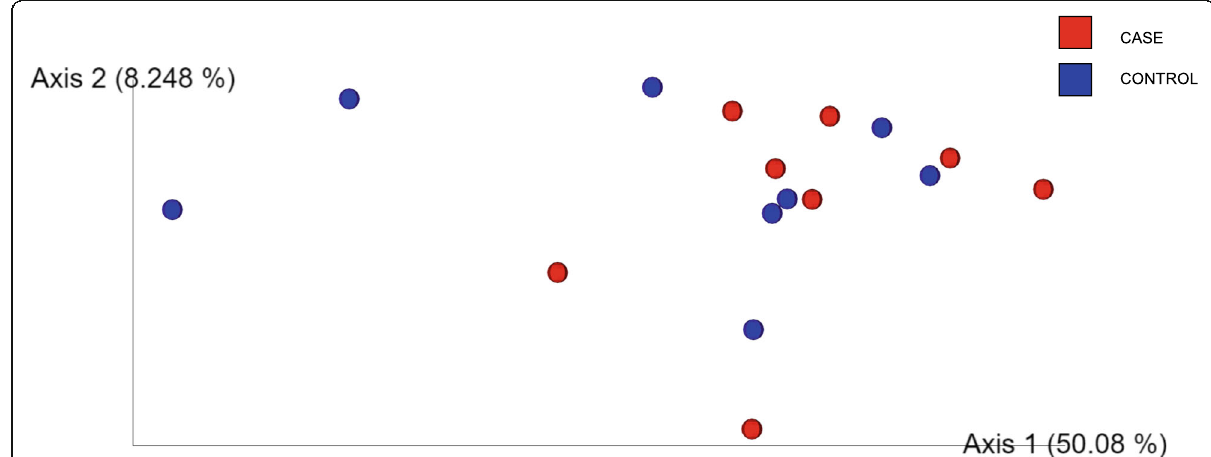
Fig. 12 Principle Coordinate Analysis (PCoA) plot showing differences in weighted UniFrac distances of samples taken from healthy sheep ’ s feet that did (case) or did not (control) develop CODD in the study. Pairwise ANOSIM tests no difference between case and control samples (R test statistic = − 803, p =